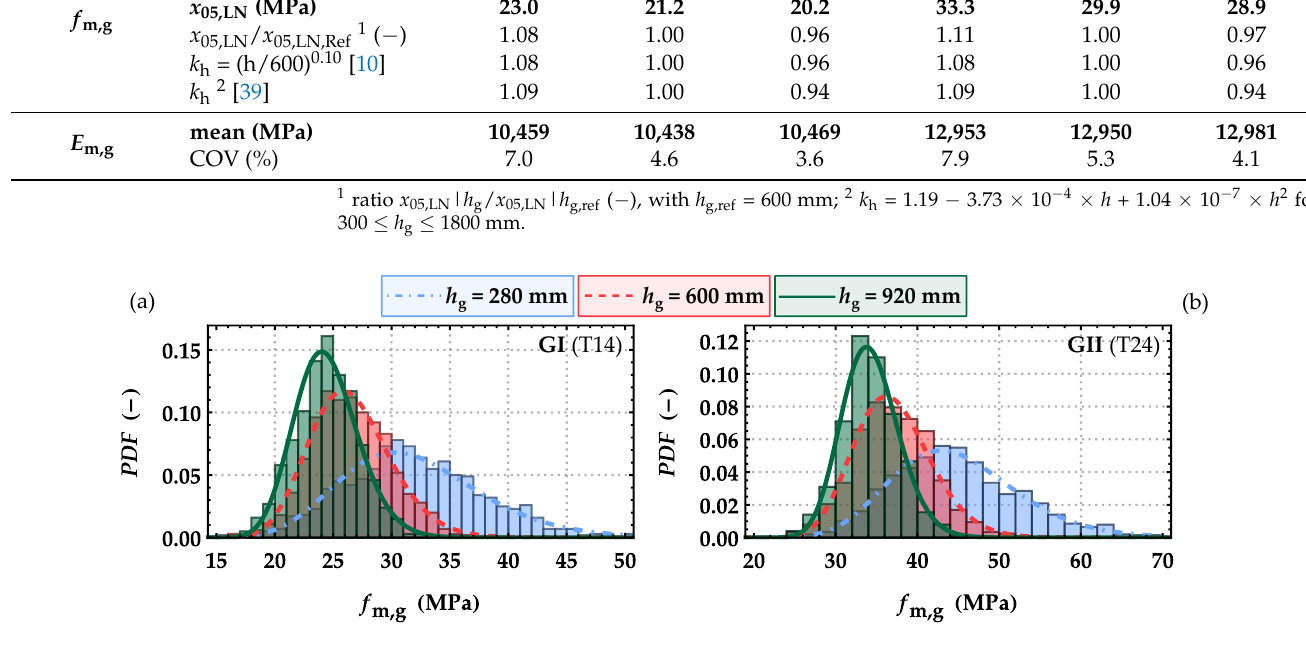
Figure 20. Histograms together with calibrated lognormal density functions of the bending strength f m,g based on simulated glulam beams of width w g = 150 mm and various depths built up from base material ( a ) GI (T14) and ( b ) GII (T24); for each setting 10 3 simulations.